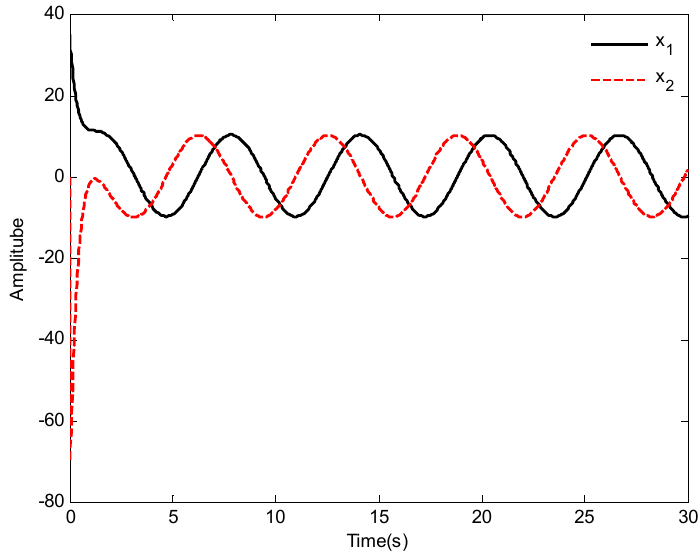
Figure 16. The curves of states x 1 and x 2